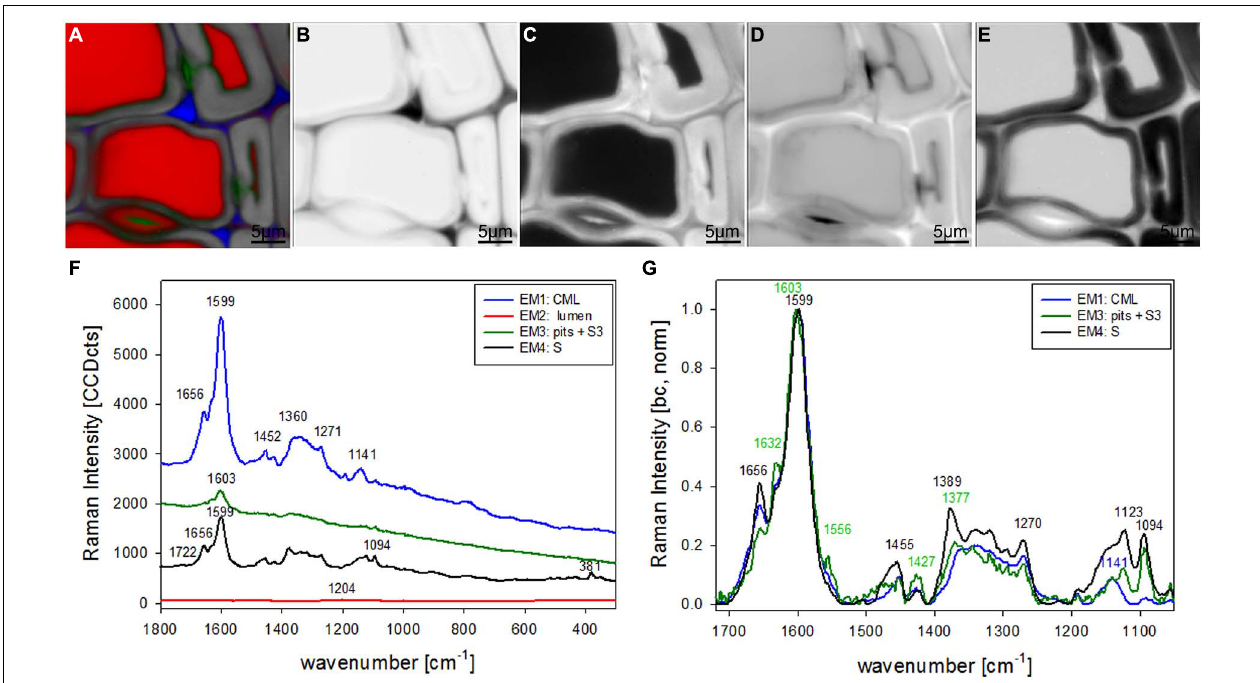
3 with high intensity in pit membrane and layer toward the lumen (S3; D), and EM 4 representing the secondary cell wall (E). The corresponding endmember spectra are shown with original background and intensity (F) and after baseline correction and normalization on the aromatic stretching vibration at 1599 cm − 1 (G)